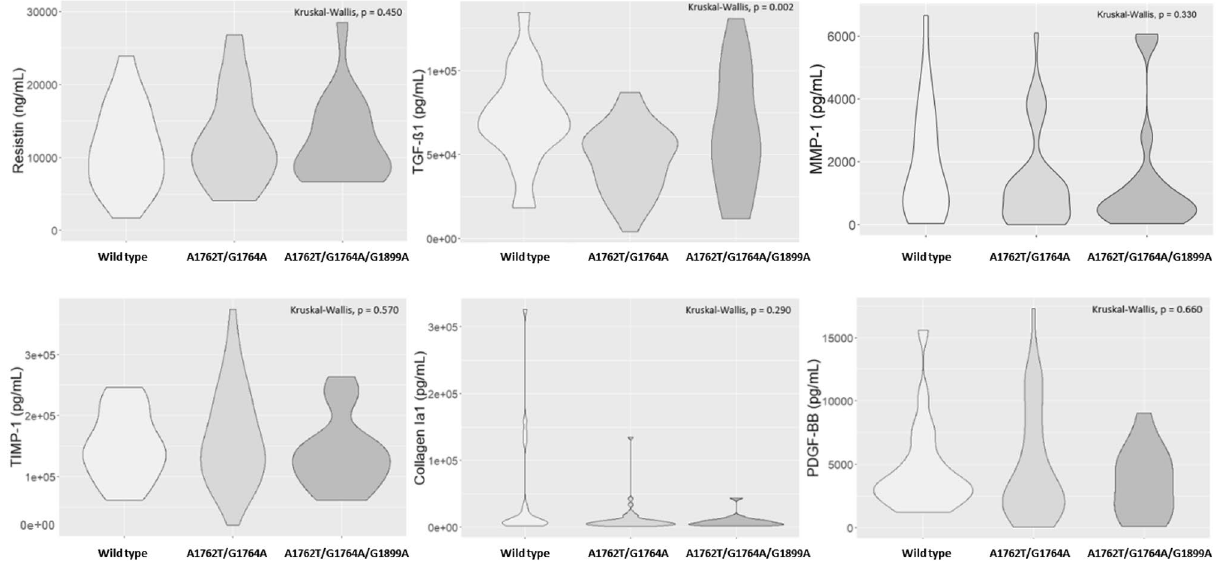
Figure 2. Distribution of fibrosis markers (resistin, TGF-β1, MMP-1, TIMP-1, collagen IA1 and PDGF-BB) according to the BCP/PC mutants (wild type; A1762T/G1764A; A1762T/G1764A/G1899A). A p value lower than 0.05 was considered statistically